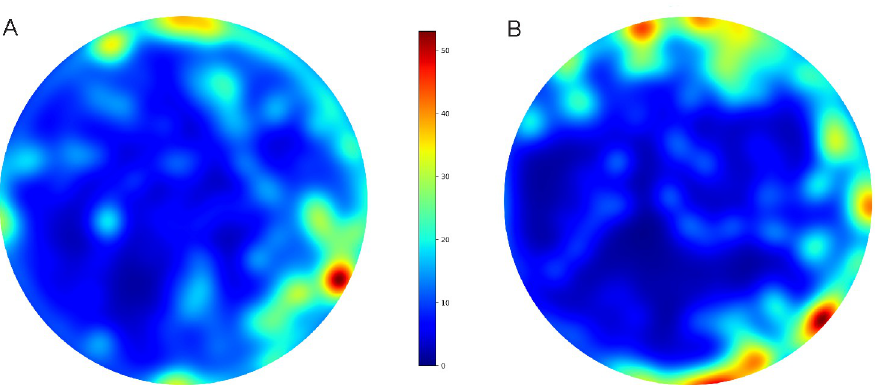
Fig 8. Higher number and duration of interaction in denser COC communities. A) Hypothetical network representation with high modularity B) Hypothetical network representation with low modularity C) Unweighted communities in CTRL D) and COC population E) weighted networks for number of interactions in CTRL F) and COC population, G) weighted networks for duration of interactions for selected CTRL H) and COC group. Each community is represented in different colour and links of different thickness represent the link weight. Ilustrations are created using the open-source software